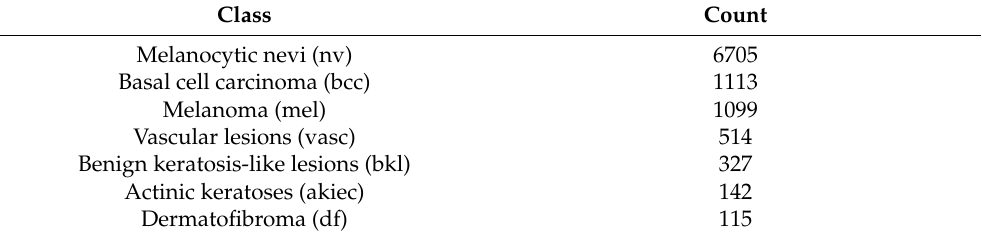
Table 1. Distribution of skin lesion images in seven major classes and total images in the dataset. taset.